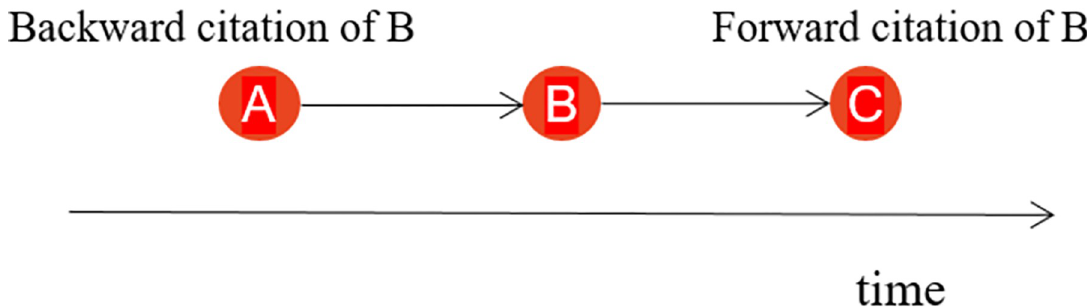
Fig 1. Illustration of “backward citation” and “forward citation”. A, B, and C are three patents. If A was cited by B and B was cited by C, then A was the backward citation of B and C was the forward citation of B.